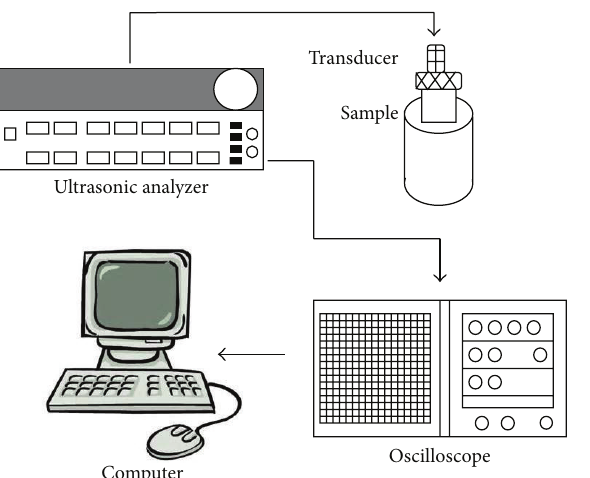
Figure 3: Layout of the ultrasonic experiment.